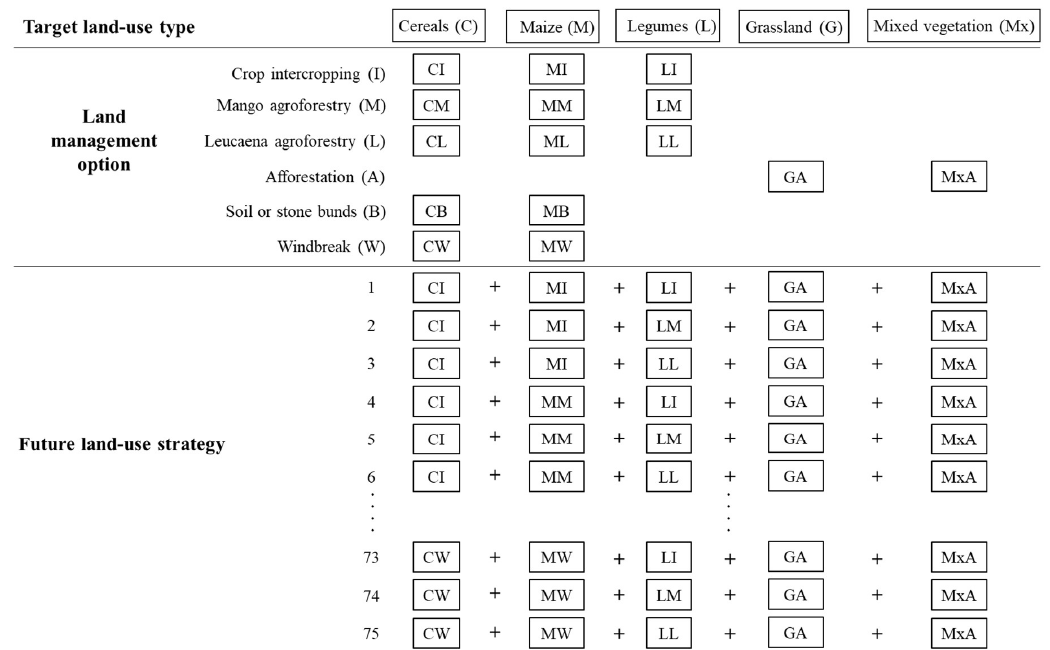
Figure 2. Development of future land-use strategies. Land-use strategies are considered as combinations of land-management options applied to target land-use types. Each box indicates which land-use management option applies to which land-use type. For instance, “CI” means a crop intercropping management applied to cereals. The meanings of abbreviated land-use management options are as below: CI: Cereal-dominant intercropping; MI: Maize-dominant intercropping; LI: Legume-dominant intercropping; GA: Grassland afforestation; MxA: Mixed vegetation afforestation; CM: Cereal intercropping with mango; MM: Maize intercropping with mango; LM: Legume intercropping with mango; CL: Cereal intercropping with leucaena; ML: Maize intercropping with leucaena; LL: Legume intercropping with leucaena; CB: Soil or stone bunds on cereals; MB: Soil or stone bunds on maize; CW: Windbreak on cereals; MW: Windbreak on maize